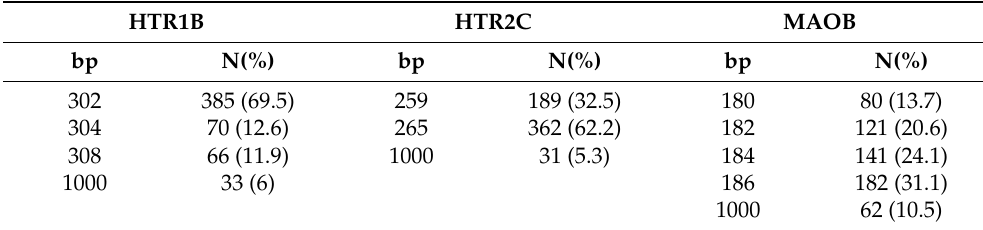
Table 1. This is a table of polymorphism